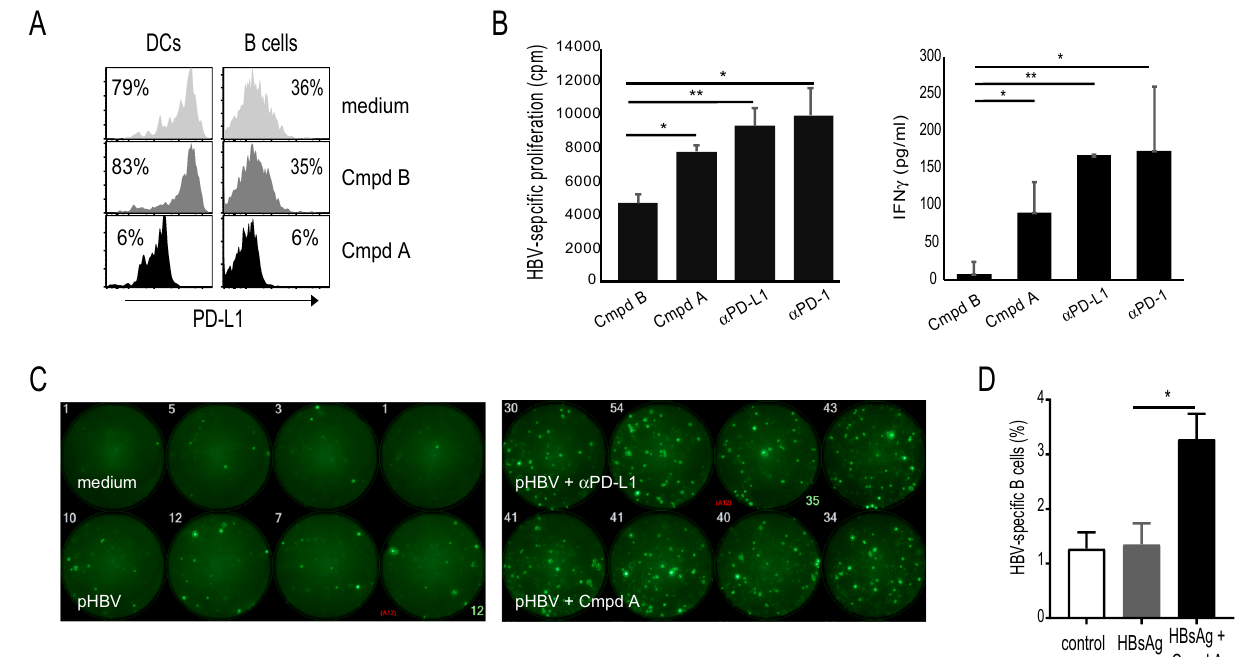
Fig. 4 Effect of compound A on ex vivo HBV-speci fi c immune responses. a PBMCs stimulated with compound A for 1 h, followed by fl ow cytometric measurement of cell surface PD-L1 percentage. b PBMCs cultured in triplicate wells with HBV peptides for 10 days and T cell proliferation (thymidine incorporation) and IFN γ secretion (ELISA) measured in the presence of compounds and antibodies. c PBMCs stimulated with compounds or antibodies overnight followed by IFN γ producing cells measured by Fluorospot. d PBMCs collected from HBV vaccinated individuals ( n = 3) on day 7 post booster vaccination were incubated with either rHBsAg alone (1 µ g/ml) or rHBsAg plus compound A at 0.5 µ M concentration for 5 days. Cells were then collected and stained for HBsAg-speci fi c B cells or plasmablasts (PBs), using Atto488-labeled rHBsAg by fl ow cytometry. The error bars represent the standard error of mean of three individuals. statistical signi fi cance (* p ≤ 0.05, ** p ≤ 0.01, *** p ≤ 0.001) was determined by unpaired two-tailed Student ’ s t test. Source data are provided as a Source data fi